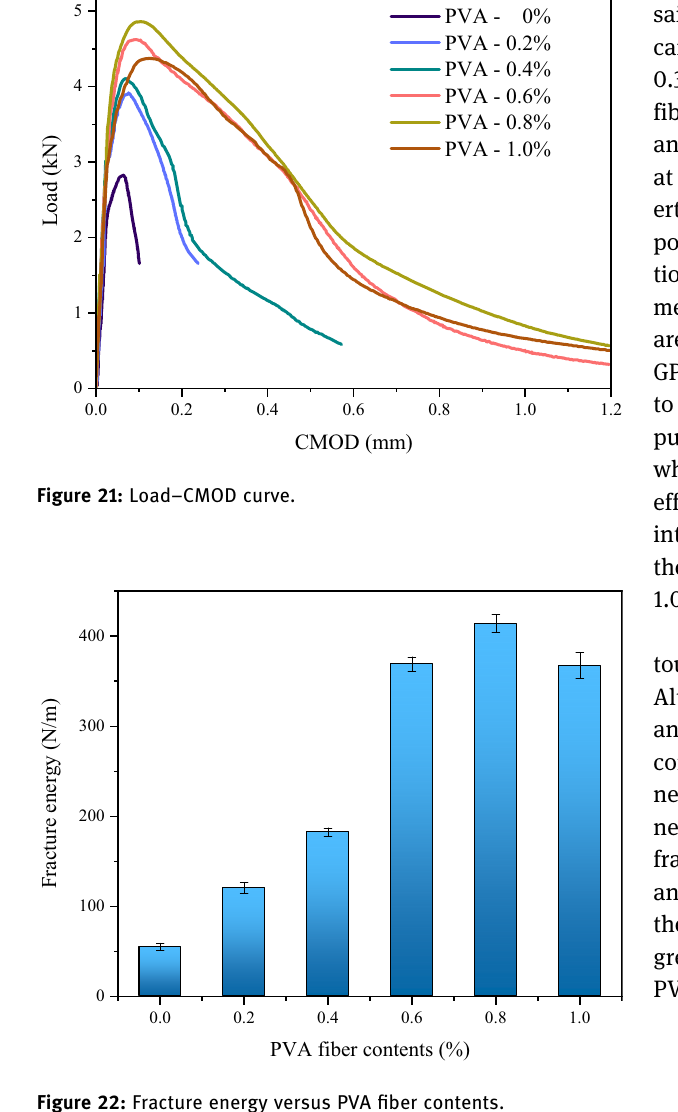
Figure 22: Fracture energy versus PVA fi ber contents.